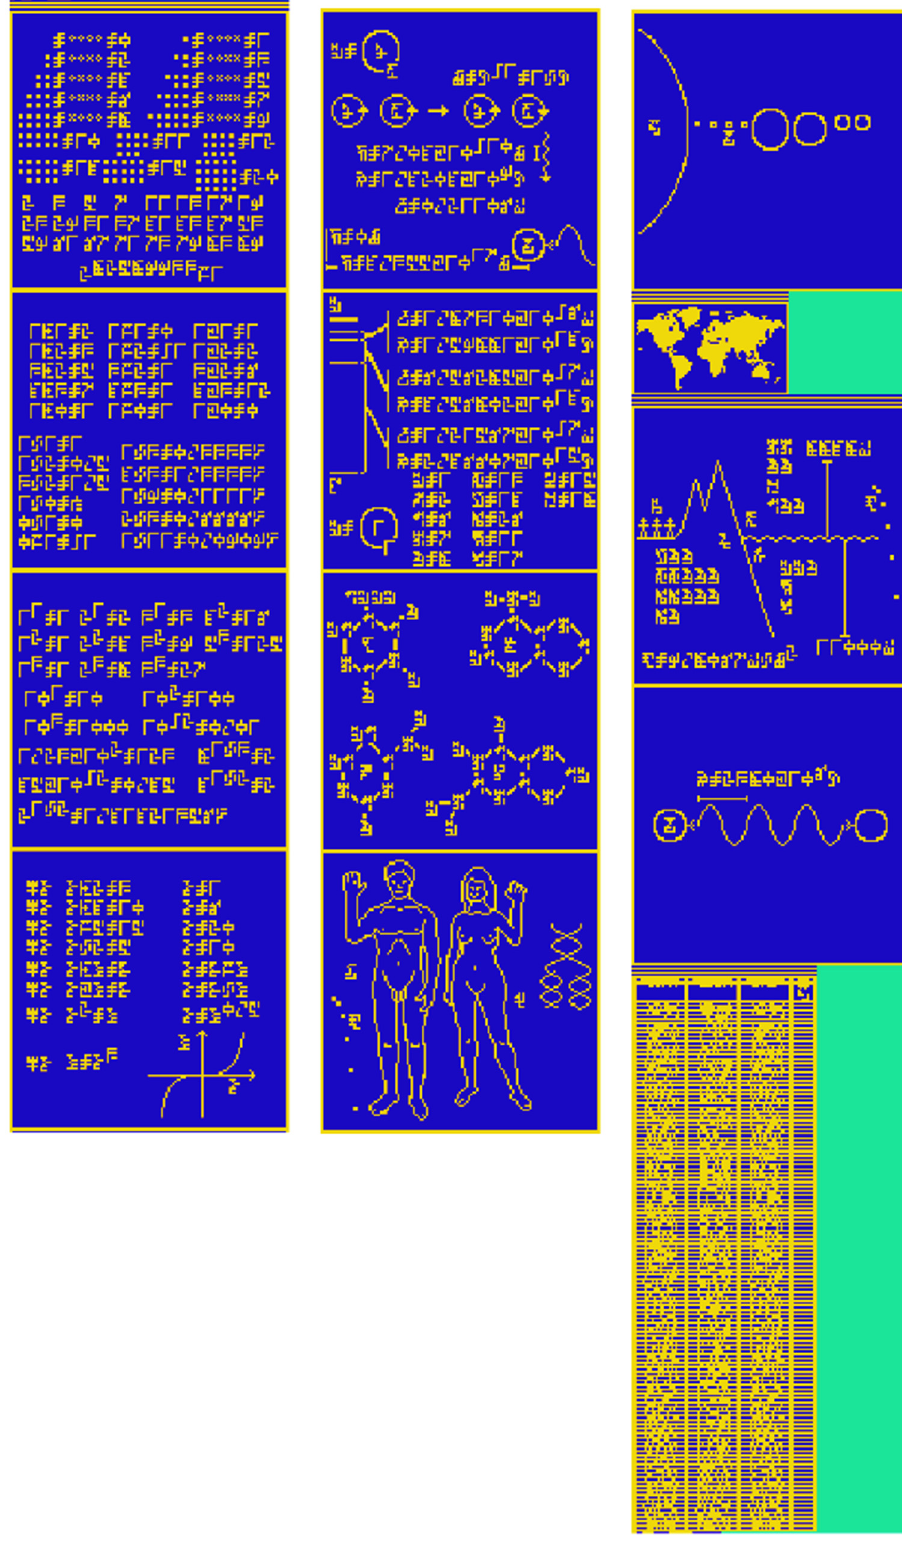
Figure A1. Detailed descriptions of the message are given in the Section 3.